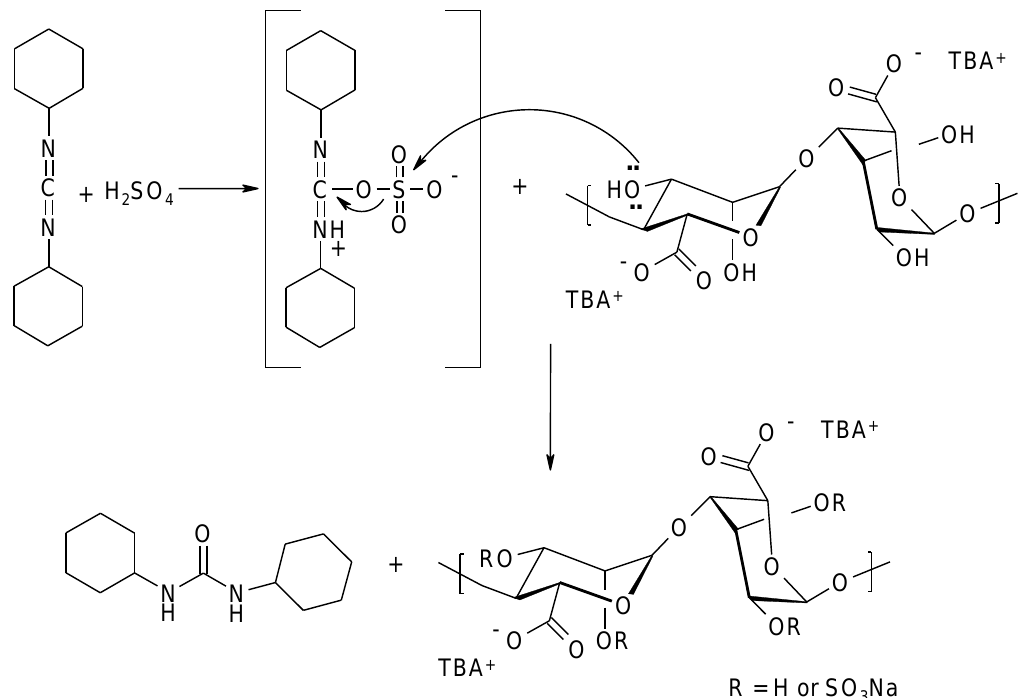
Figure 9. Formation of sulphate alginate derivatives using DCC and sulfuric acid. The DCC-H 2 SO 4 adduct reacts with the nucleophilic hydroxyl groups of the alginate. The reaction products were characterized based on 13 C-NMR. No change in the chemical shift was observed in the spectra for C-1 and C-6. It was found that sulphate esters are formed with either one or two hydroxyl groups at C-2 and C-3. The use of a strongly acidic reagent causes a significant reduction in the molecular weight of the polysaccharide. The average molecular weight decreases during the reaction from 100 to 10 kDa, but this has no effect on the M/G ratio.